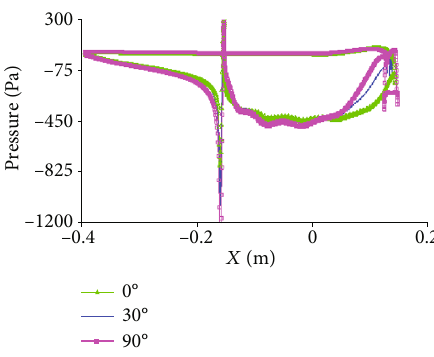
Figure 10: Static pressure distribution curve on the surface of the Fan-wing with single leading edge winglet ( v = 12 m/s, α = 0 °